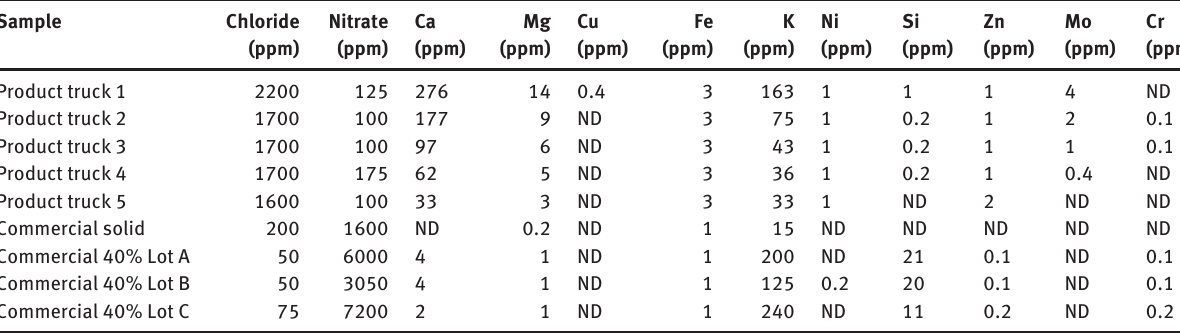
Table 5 Anion and metal analyses of carbon purified 40 wt% aqueous NaNO